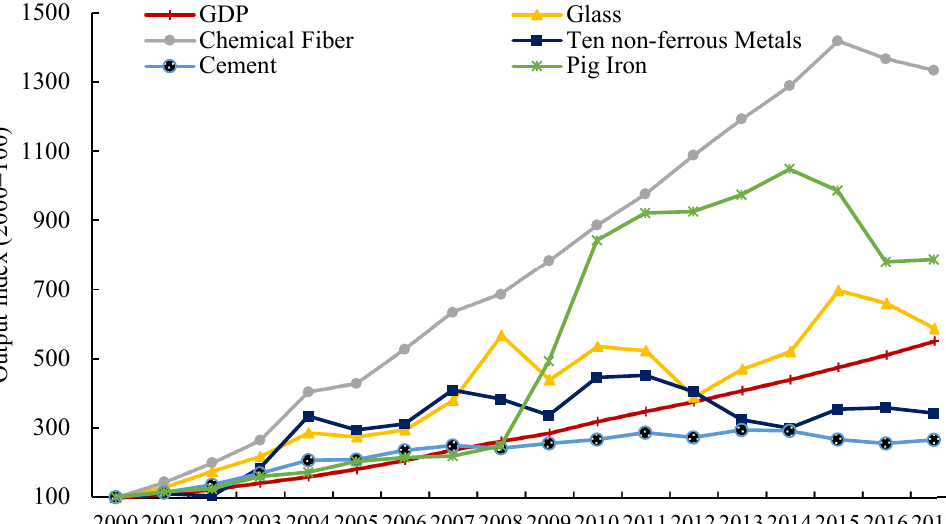
Figure 3. Zhejiang energy-consuming product output and GDP index (2000–2017). Data source: Zhejiang Statistical Database, CEIC, and author.